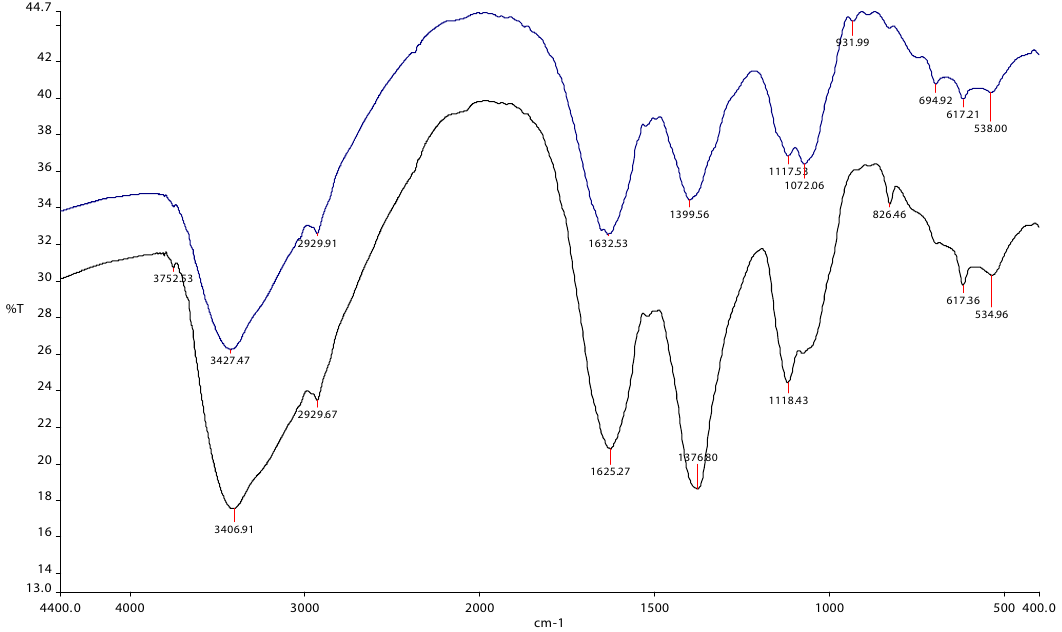
Figure 3: IR spectra of C. gileadensis extracts ( blue color ) and C. gileadensis AgNPs ( black color )